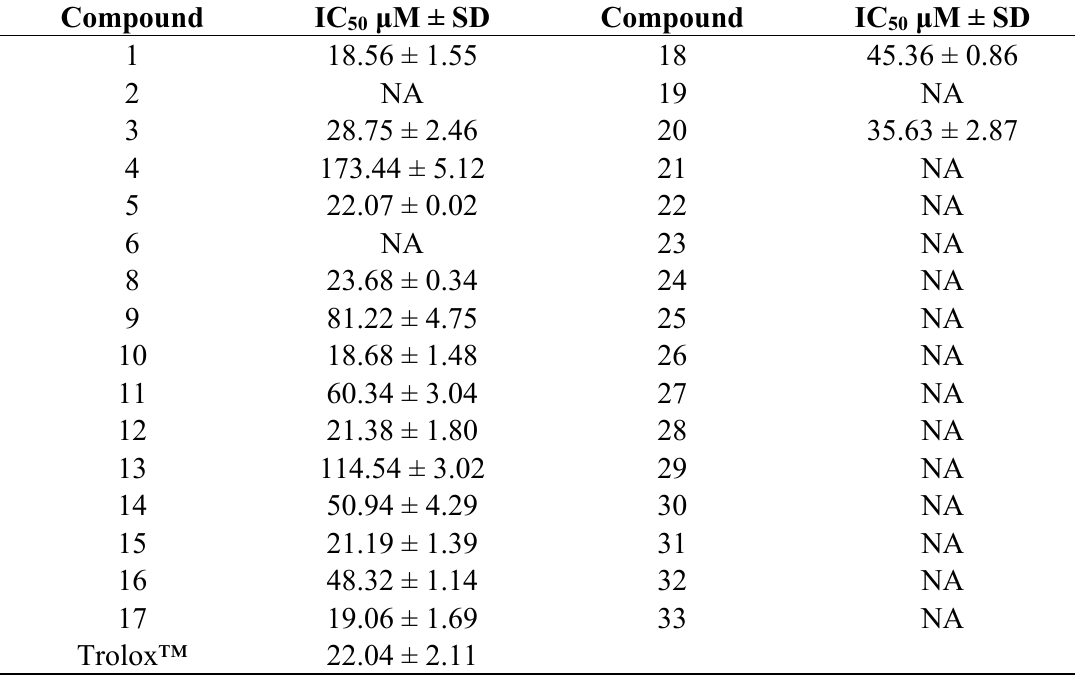
Table 1. Screening results of DPPH radical scavenging activity of phenols 1–6 and prenylated phenols derivatives 8 – 33